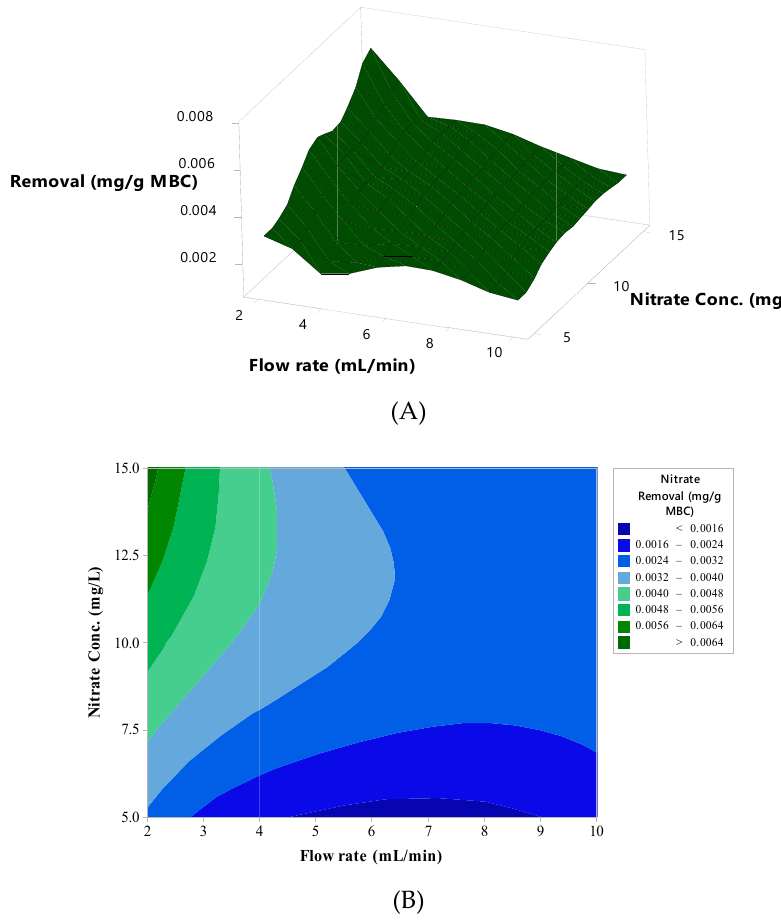
Figure 12. Surface (A) and contour (B) plots for nitrate removal with MBC.